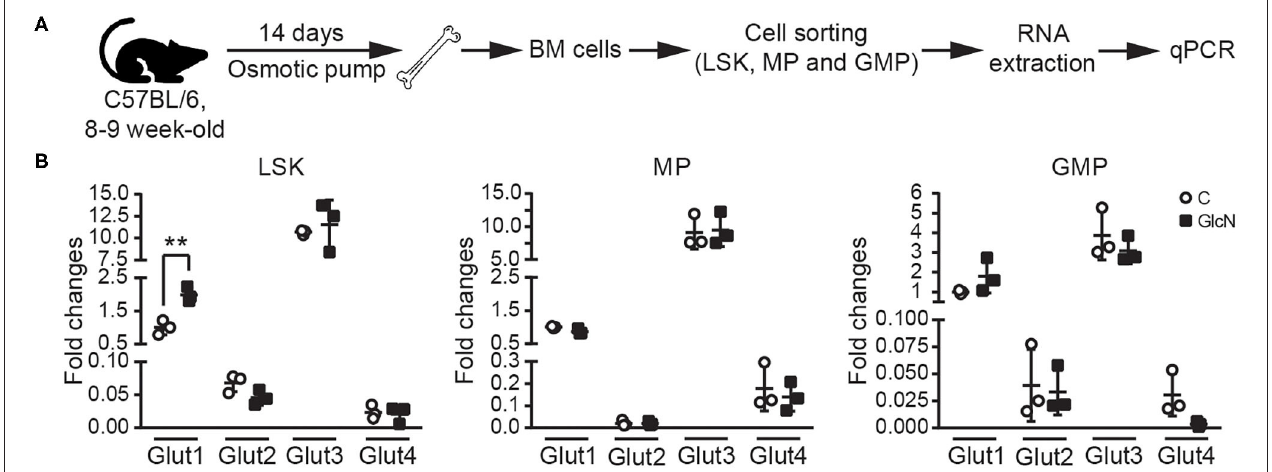
FIGURE 4 | The influence of GlcN treatment in the expression of glucose transporters of hematopoietic stem and progenitor cells. (A) The schematic of glucose transporter expression analysis in sorted LSKs, MPs, and GMPs. (B) Relative mRNA expression of Glut1, 2, 3 and 4 in LSKs, MPs, and GMPs were determined by quantitative reverse transcription-PCR. GlcN treatment significantly increase Glut1 expression in LSKs. The quantified results are presented as the mean ± standard deviation. ** P < 0.01.